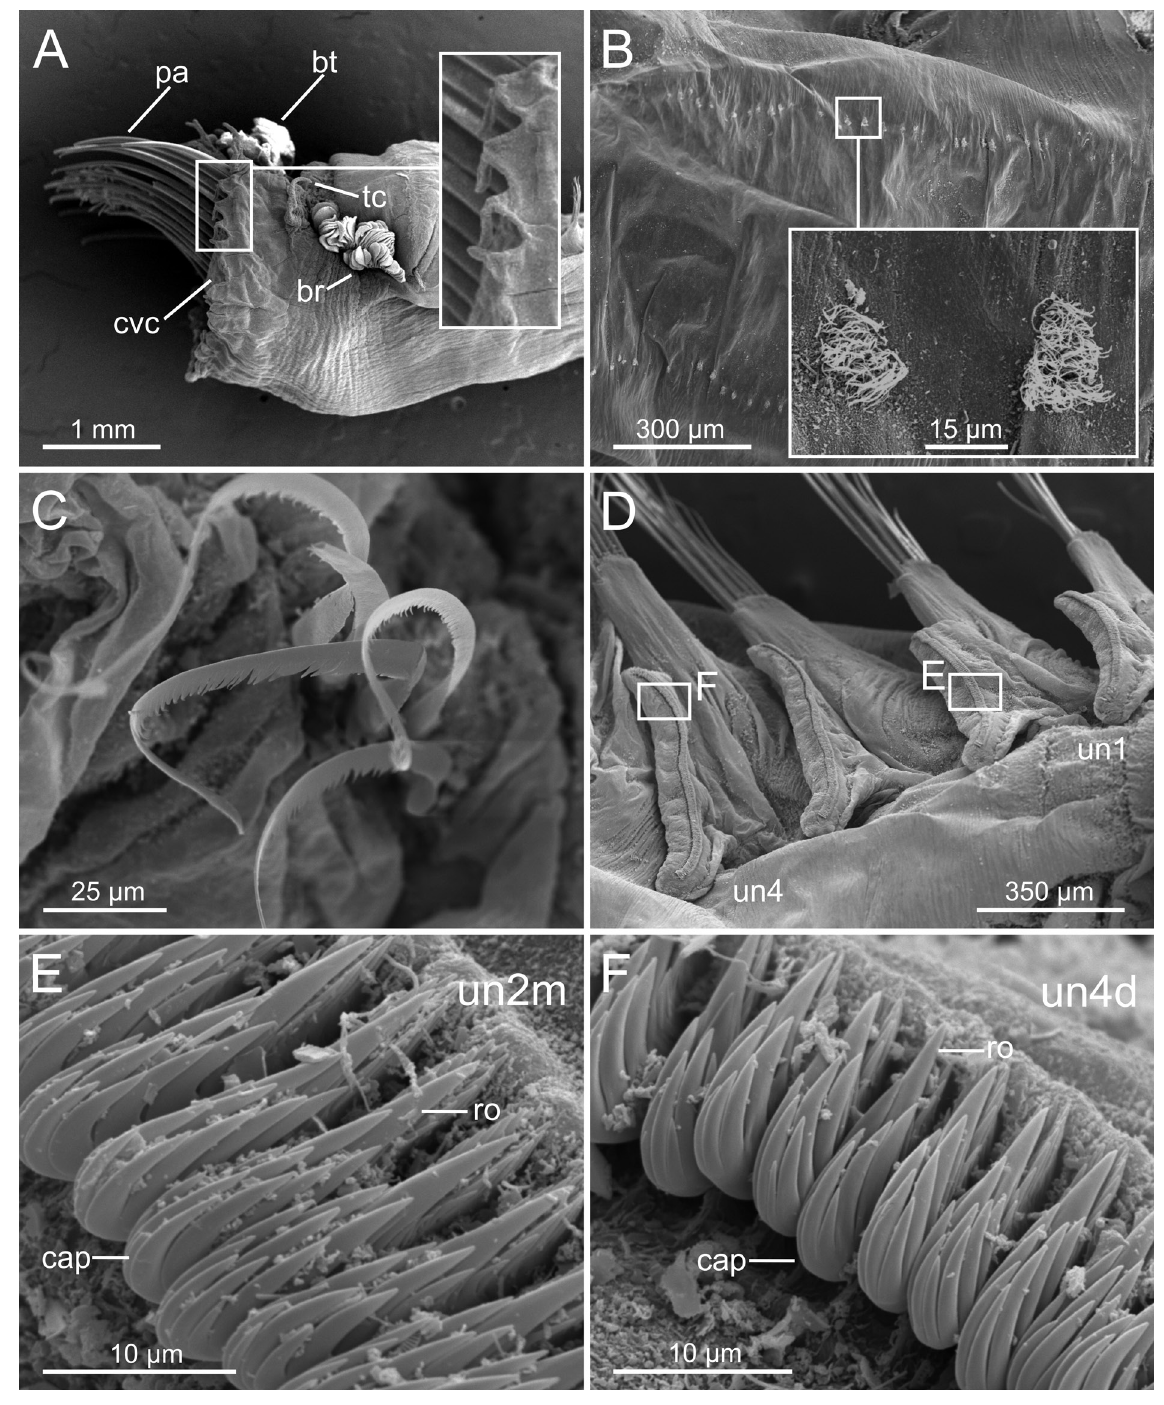
Fig. 5. Amphictene auricoma (O.F. Müller, 1776). SEM micrographs from two large specimens (BIOICE sample 2998, IINH-40213). A . Anterior end, left lateral view (framed: cirri of opercular rim, detail). B . Ventral rows of ciliated tufts (framed: two tufts, detail). C . Notochaetae; distal end. D . Uncinigers 1 to 4. E . Unciniger 2, median uncini (framed in D). F . Unciniger 4, dorsal uncini (framed in